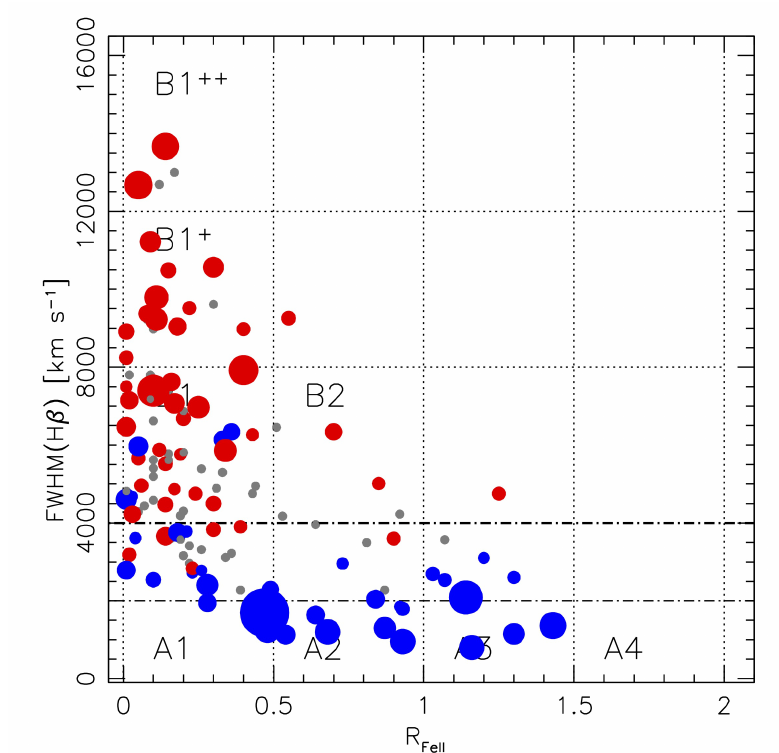
Figure 2. Bias of the M BH estimates in the optical E1 plane FWHM(H β ) vs. R FeII , for the full sample of Sulentic et al. [6]. Grey symbols represent differences | ∆ log M | = | log M ( CIV ) − log M ( H β ) | ≤ 0.3, blue dots ∆ log M > 0.3, red circles ∆ log M < − 0.3. The size of the circles is proportional to the amplitude of the difference, with the largest blue circles showing CIV masses in excess by a factor 100. Mid-sized circles indicate a disagreement of a factor ≈ 10. The labels identify the spectral types as described in Section 4 and the thick dot-dashed line at 4000 km s − 1 shows the boundary between Population A and Population